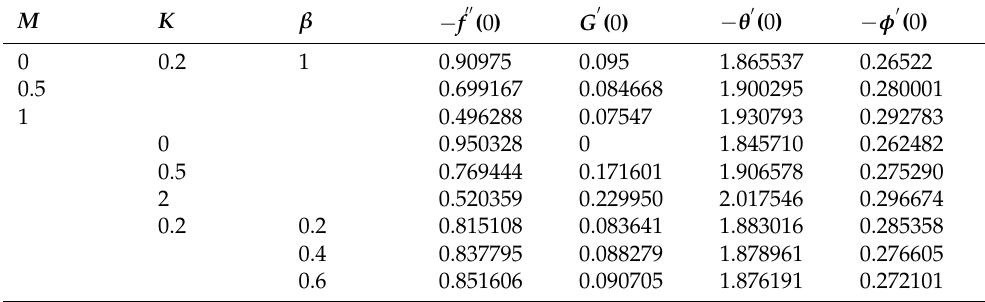
Table 2. Numerous standards of − f (cid:48)(cid:48) ( 0 ) , G (cid:48) ( 0 ) , − θ (cid:48) ( 0 ) , and − φ (cid:48) ( 0 ) for altered standards of M , K , and β at Pr = 6.2, Sc = 0.22, Ec = 0.02, and Kc = 0.1.